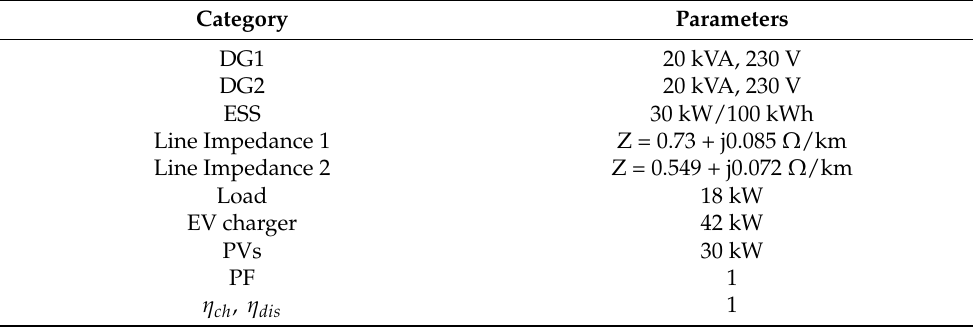
Table 2. Model parameter of stand-alone MG.